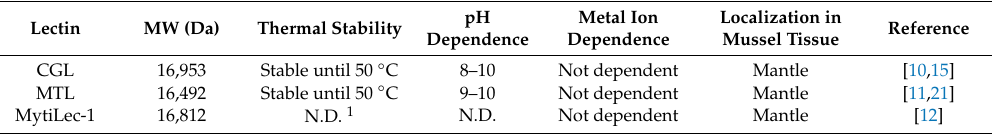
Table 1. Properties of CGL, MTL, and MytiLec-1.